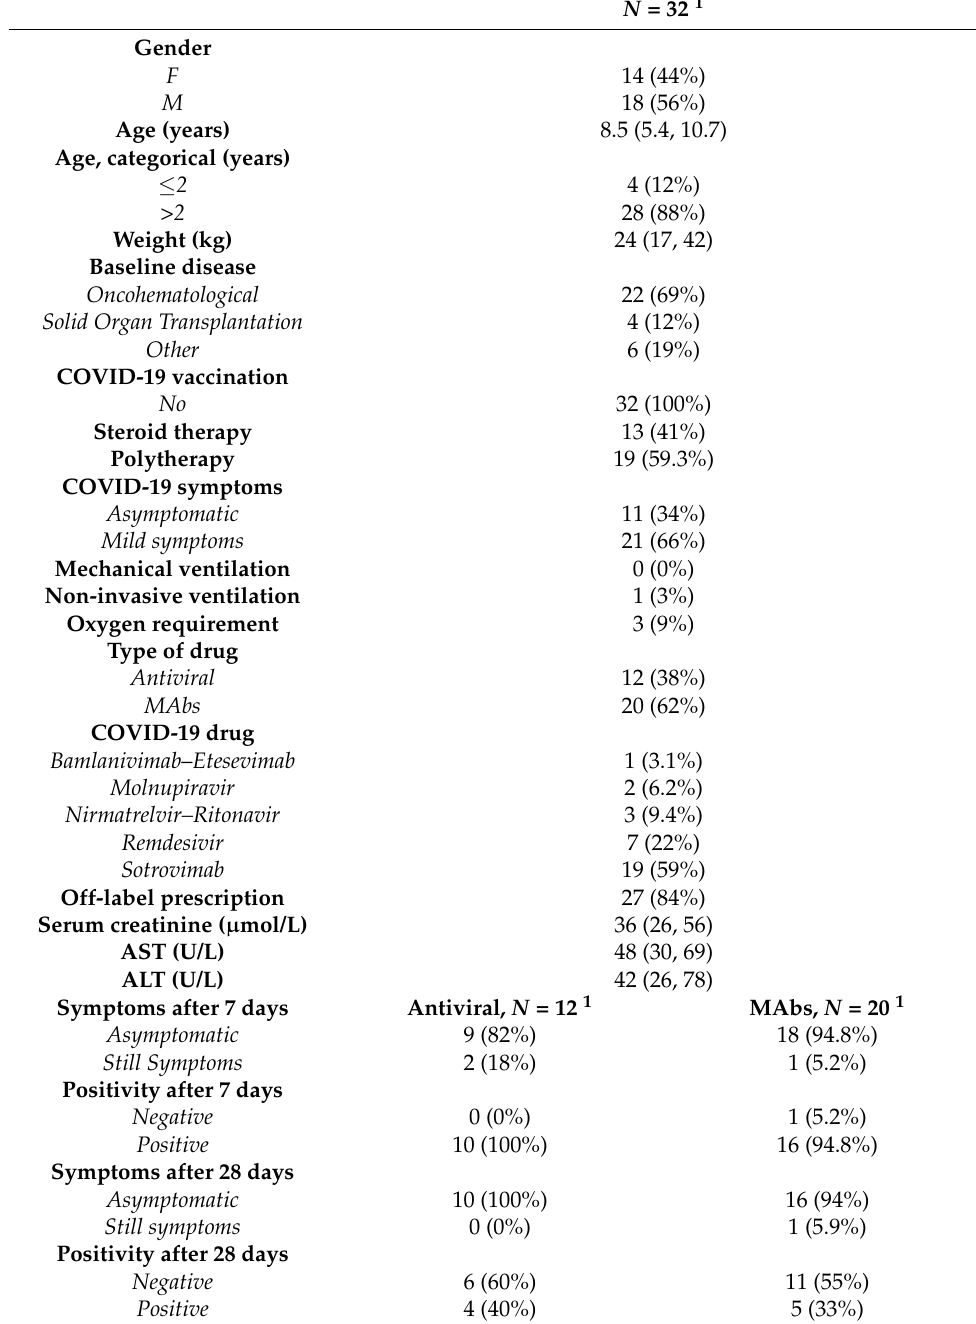
Table 1. Baseline